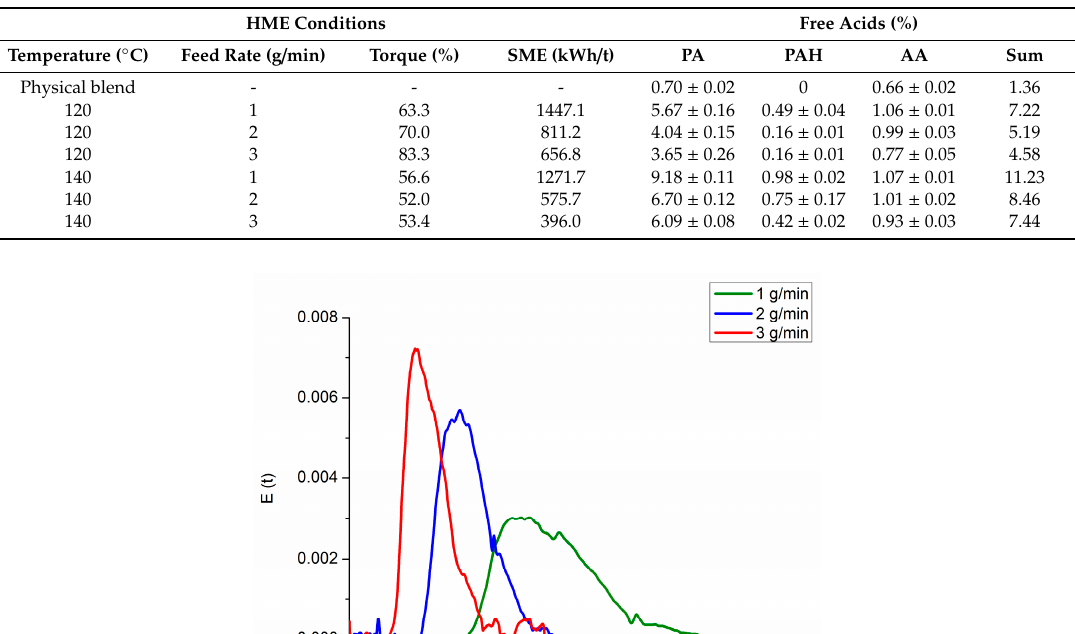
Table 1. Hot-melt extrusion process conditions for the placebo extrudates and contents of free acids upon extrusion.